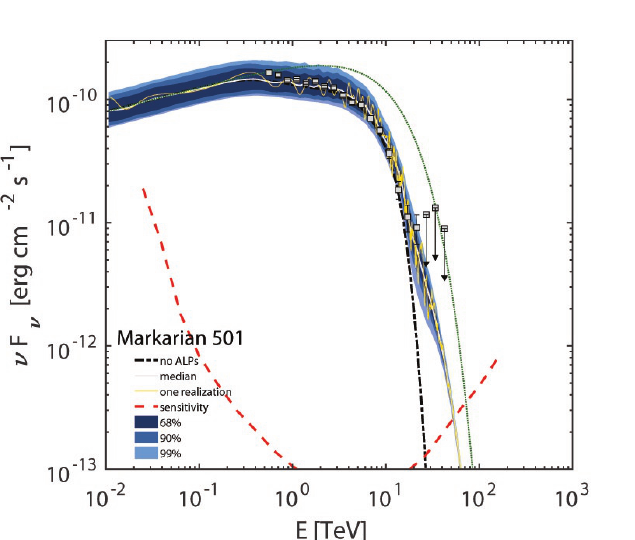
Figure 25. We exhibit the observed SED of Markarian 501 versus the observed energy E . The dotted- dashed black line corresponds to conventional physics, the solid light-gray line to the median of all the realizations of the photon/ALP propagation process and the solid yellow line to a single realization with a random distribution of the domain lengths and of the orientation angles of the extragalactic magnetic field. The dotted green line is the intrinsic SED and the dashed red line represents the CTA sensitivity for the South site and 50 h of observation. The filled area is the envelope of the results on the percentile of all the possible realizations of the propagation process at 68% (dark blue), 90% (blue) and 99% (light blue), respectively. The light gray squares are the spectrum detected by HEGRA [257]. (Credit